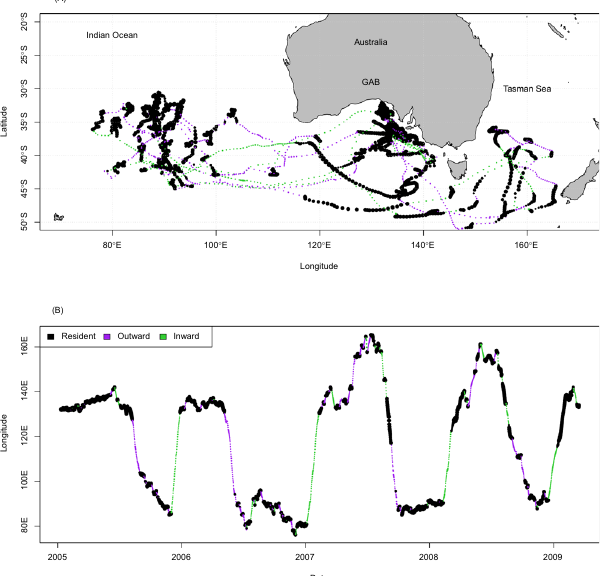
Figure 2. ( A ) The estimated migratory movements of an individual juvenile southern bluefin tuna. Locations are coloured according to the most likely movement state classification, with black identifying periods of residence, purple identifying migrations away from the Great Australian Bight (GAB) and green identifying migrations toward the GAB. ( B ) The migration pattern shown via the predominant east-west (longitude) movement component.